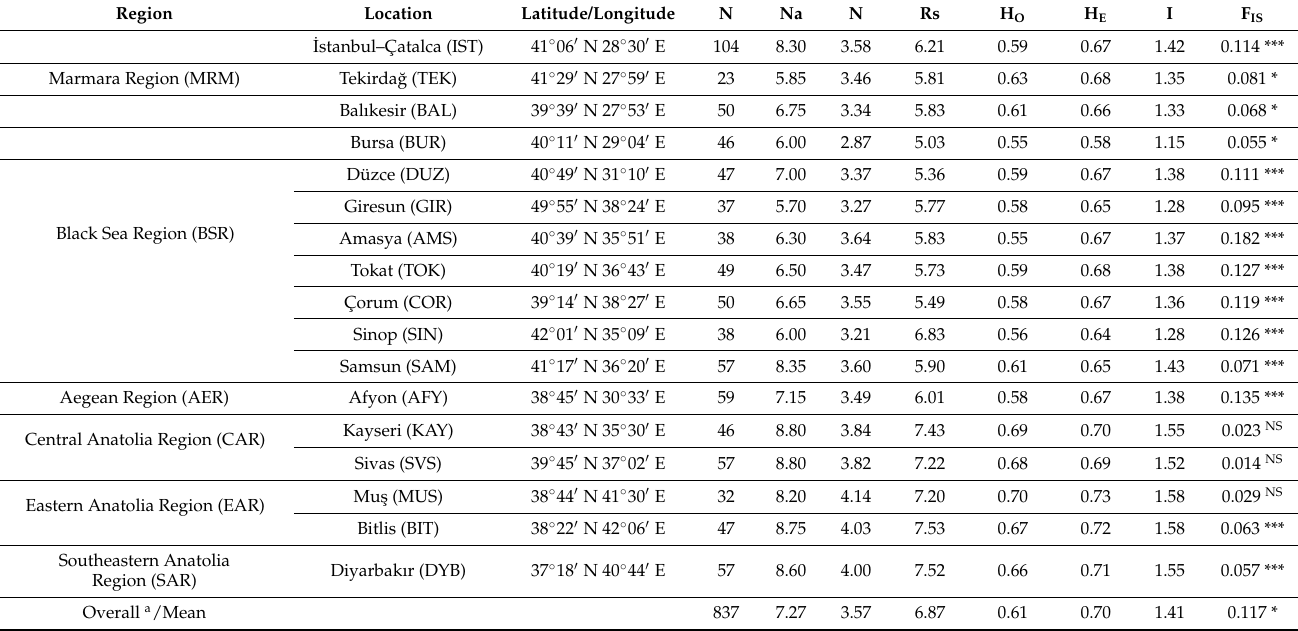
Table 1. Genetic diversity of populations of Turkish water buffalo populations. The number of individuals (N), the mean number of alleles (N a ), the number of effective alleles (N e ), allelic richness (R s ), observed heterozygosity (H O ), unbiased expected heterozygosity (H E ), Shannon’s information index (I) and deficit of heterozygotes (F IS ). Region Location Latitude/Longitude Marmara Region (MRM)